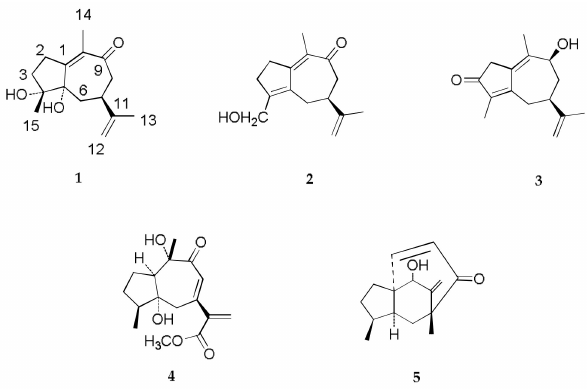
Figure 1. Structures of compounds diarthronchas A–D ( 1 – 4 ) and daphnauranol B ( 5 ).